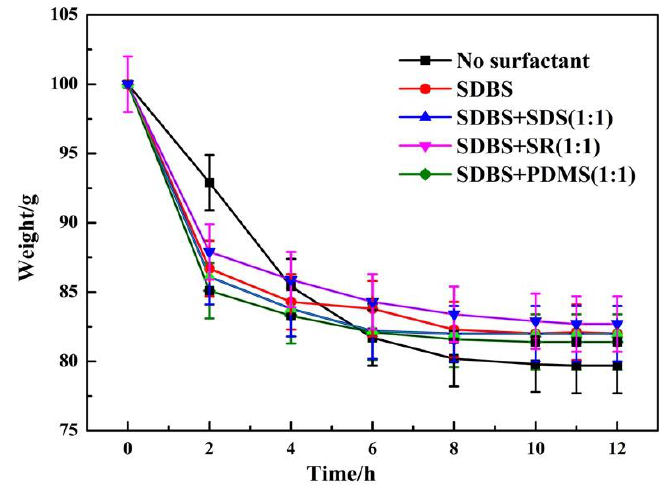
Figure 7. Weight of phosphogypsum changes with time after the modification of the compound surfactants.